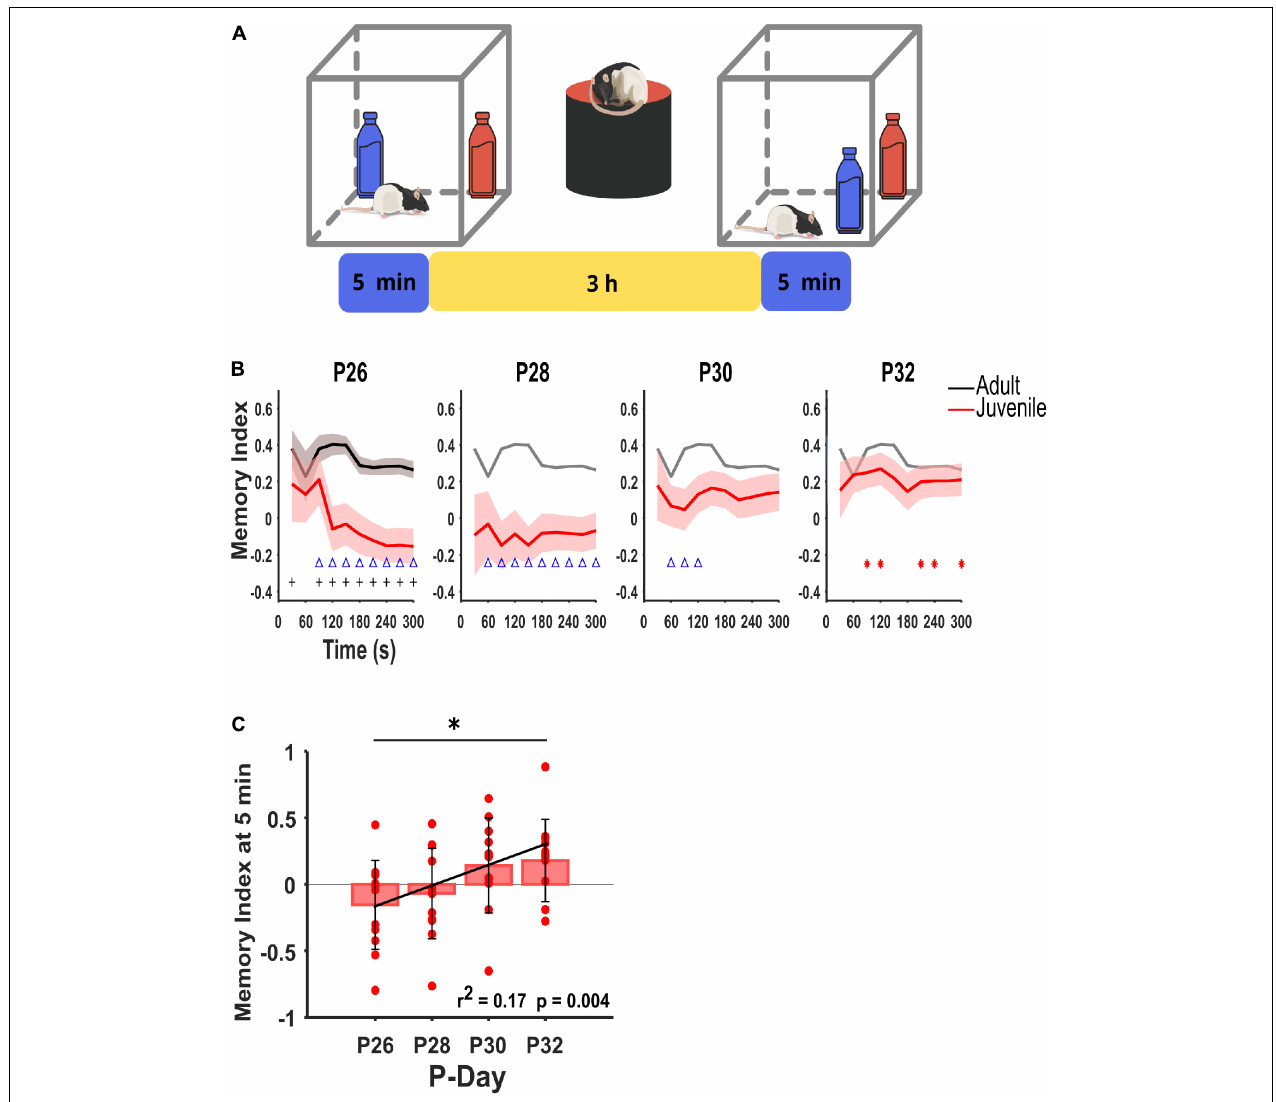
FIGURE 1 | Hippocampal-dependent memory onset. (A) Experimental design. Rats were tested on an OPR task on different postnatal days (P26, P28, P30, P32) or in adulthood (P90). Each animal explored the test arena with two identical objects for 5 min during the encoding and recall phases, with a retention phase of 3 h, where the animal rested on top of a flowerpot. One of the objects was moved to a novel location during the recall phase, while the other remained in the same place. Rat figures were obtained from the GitHub repository (Eackermann, 2018). (B) Average memory index (Mean ± SEM) during the recall phase throughout postnatal days. The memory indexes are shown for the entire task duration (5 min, 30 s/bin). The black line indicates adult rats (P90), then the same line was repeated in gray for referencing the following P-days. Juvenile subjects (P26–32 are indicated by the line in red). The P90 group showed significant differences against chance level (zero memory index); they were only shown at P26 as reference (" + "; p < 0.034, two-sided Wilcoxon signed-rank). Only P32 juvenile rats showed a significant memory index against chance level ( p < 0.042, two-sided Wilcoxon-signed-rank, dot in red). P26–P30 rats showed non-significant differences concerning chance ( p > 0.083, two-sided Wilcoxon rank-sum). Only at P32 juvenile rats show no significant difference with respect to adults ( p > 0.082, two-sided Wilcoxon rank-sum, triangle in blue). P26 and P28, n = 12; P30 and P32 n = 11. (C) Average (Mean ± SEM) of the cumulative memory index at 5 min for each postnatal day (P26, P28, P30, and P32). The memory index becomes positive and significant only at P32 [ ∗ p = 0.043, one-way repeated ANOVA, F ( 3 , 11 ) = 3.057], followed by the Bonferroni’s post-hoc test, p = 0,038 between P26 and P32. Linear regression analysis between the OPR cumulative time (5 min) against P-days indicate a positive and significant correlation ( r 2 = 0.170; p =